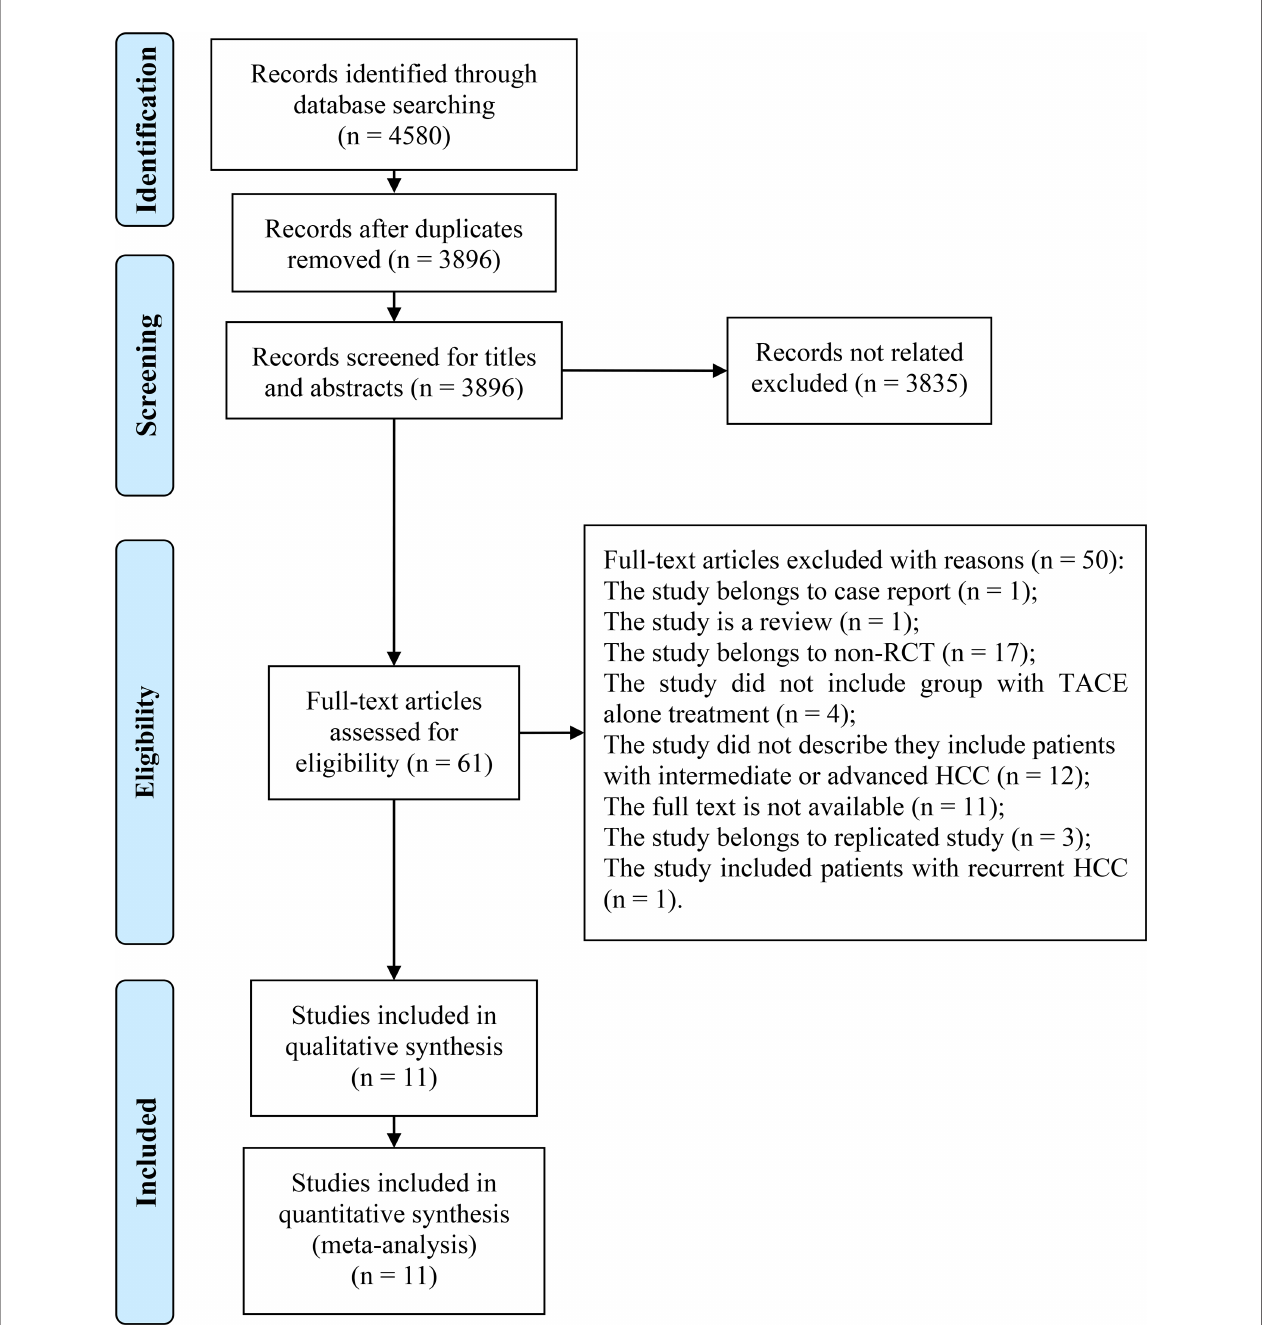
FIGURE 1 | Flow diagram of literature selection. A fl ow diagram of the literature selection process is shown. We found 4580 citations after searching eight online databases. The titles and abstracts were then reviewed for relevance. We identi fi ed 61 citations and reviewed them using their full-texts. Finally, for qualitative and quantitative synthesis, we included eleven RCTs. RCT, randomized controlled trial; TACE, transcatheter arterial chemoembolization; HCC, hepatocellular